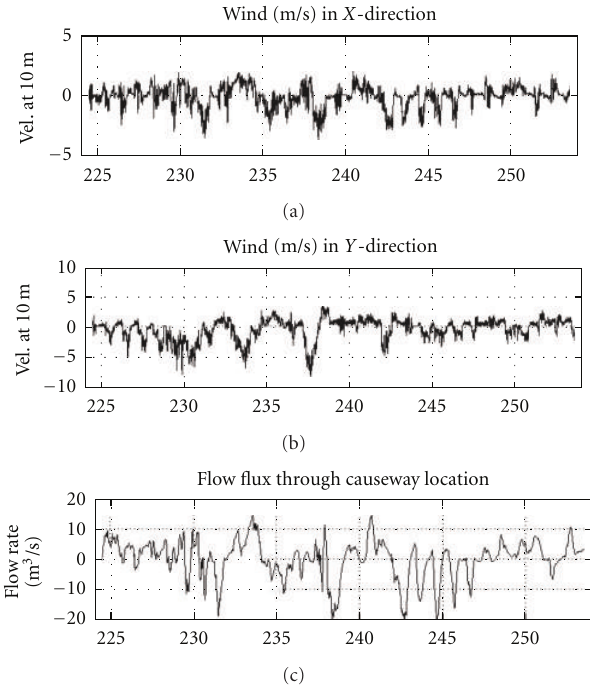
Figure 10: Time series of the exchange flows passing through the cross-section at a location indicated by the white straight line in Figure